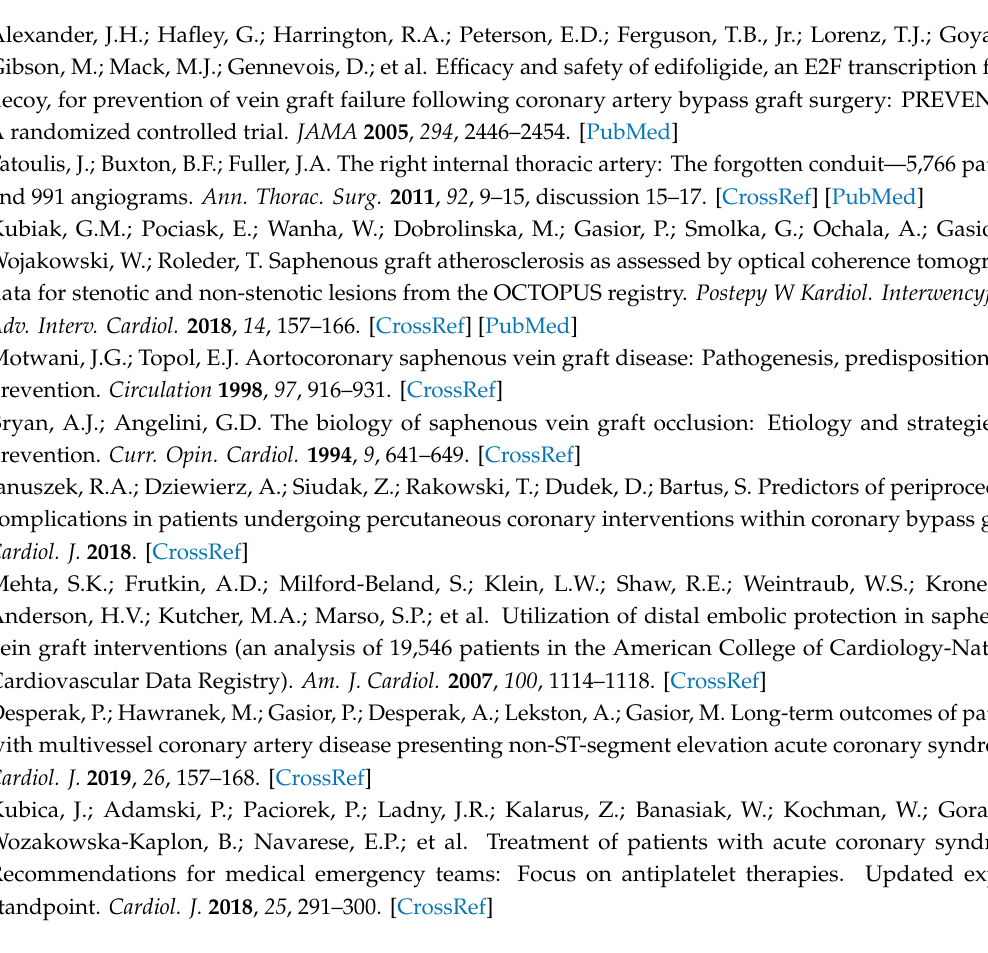
Supplementary Materials: The following are available online at http: // www.mdpi.com / 2077-0383 / 9 / 4 / 1198 / s1; Table S1: 1-year follow up according to the use of embolic protection devices in the DES sub-group, Table S2: 1-year follow up according to the use of embolic protection devices in the no-thrombectomy sub-group, Table S3: Impact of the stent diameter on the 1-year follow up